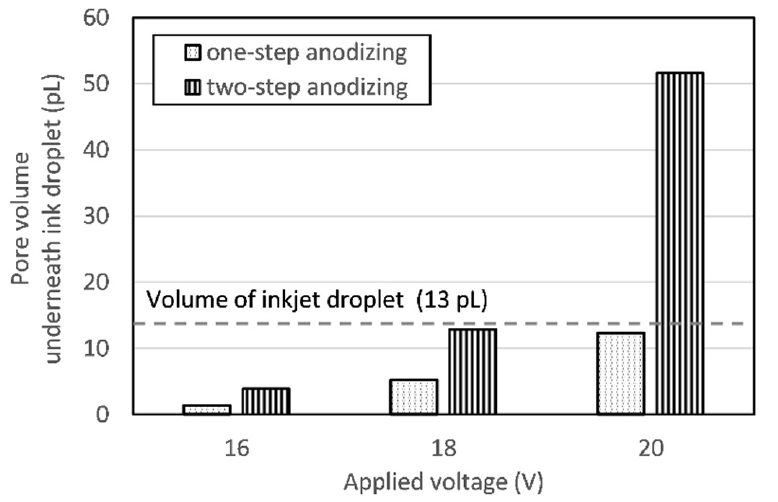
Figure 10. Pore volumes beneath a 13 pL inkjet droplet on one-step and two-step AAO films according to applied voltage.